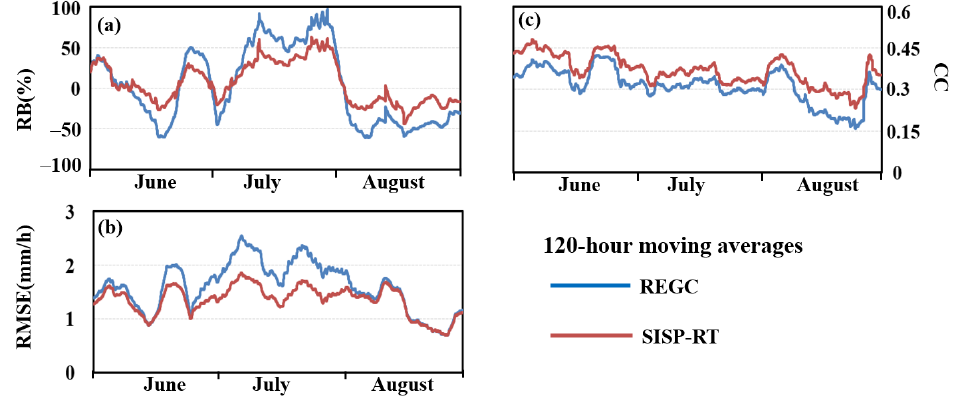
Figure 9. Time series of RB ( a ), RMSE ( b ), and CC ( c ) of the REGC and SISP-RT against the CMPA in Jun–Aug 2019. All lines are obtained from 120 h moving averages of the original time series.